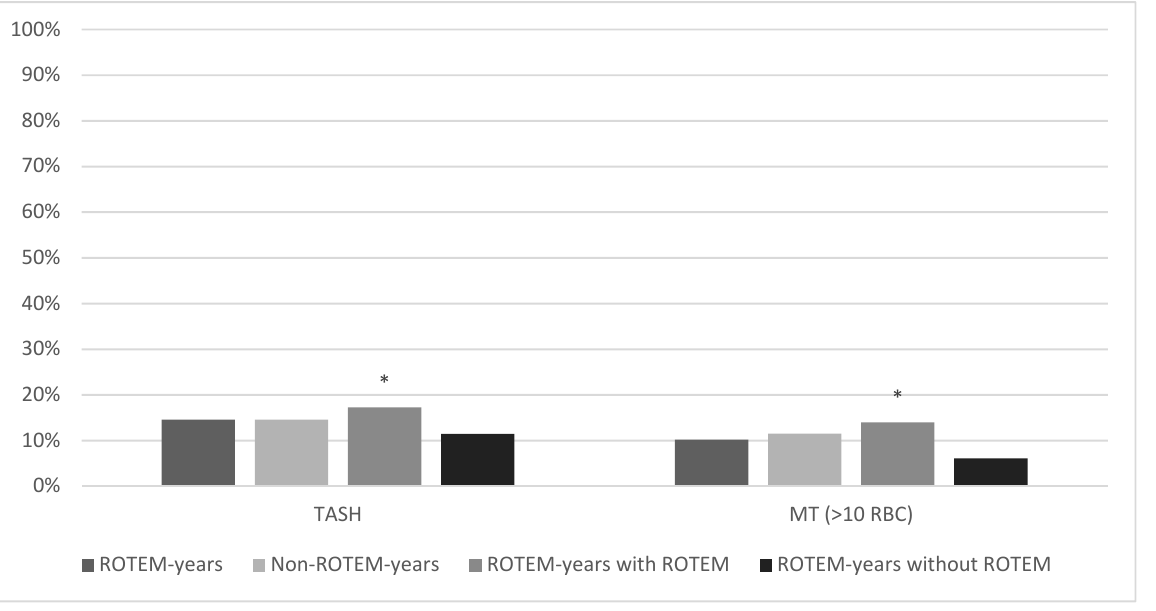
Figure 4. Trauma Associated Severe Hemorrhage score and massive transfusion rate (>10 RBC). * marks statistical significance ( p ≤ 0.001).